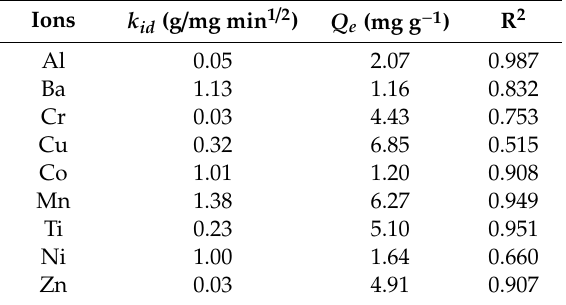
Table 5. Kinetic parameters for intra particle di ff